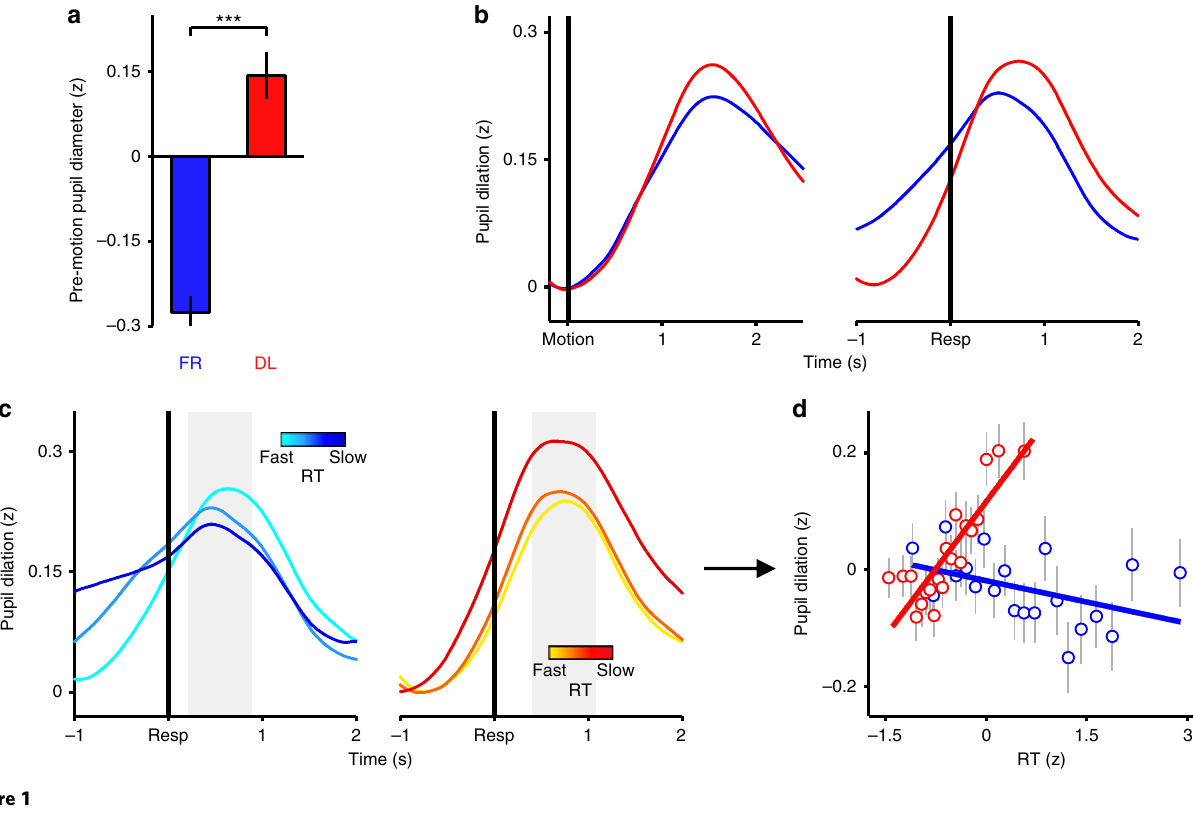
NATURE COMMUNICATIONS|8:14299|DOI: